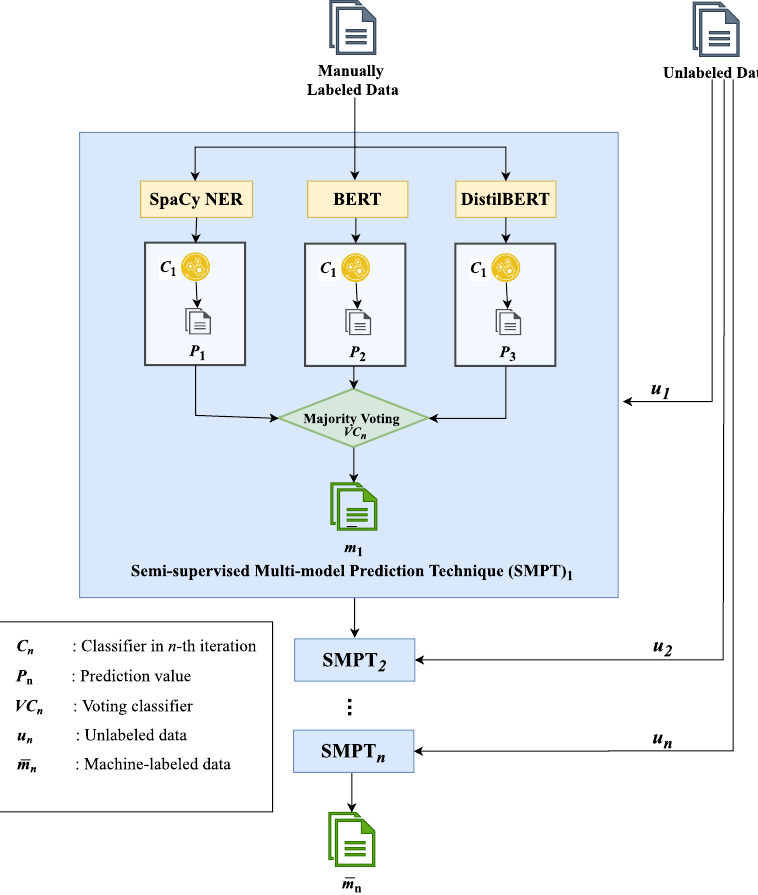
Figure 3. SMPT method for ingredient entity data